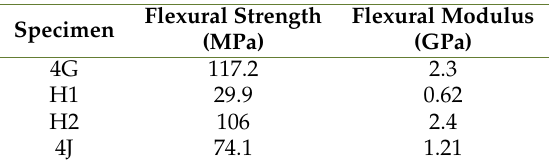
Table 3. Flexural strength and modulus values of 4J, 4G, H1 and H2 laminates.